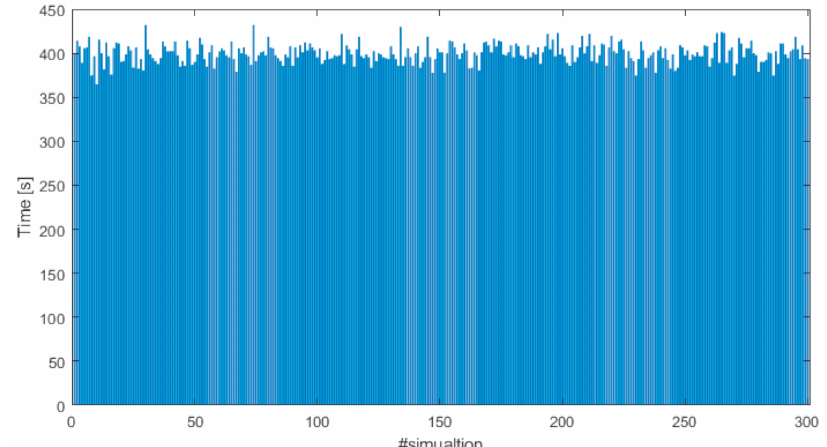
Figure 11. Docking maneuver duration in the 300 Monte Carlo